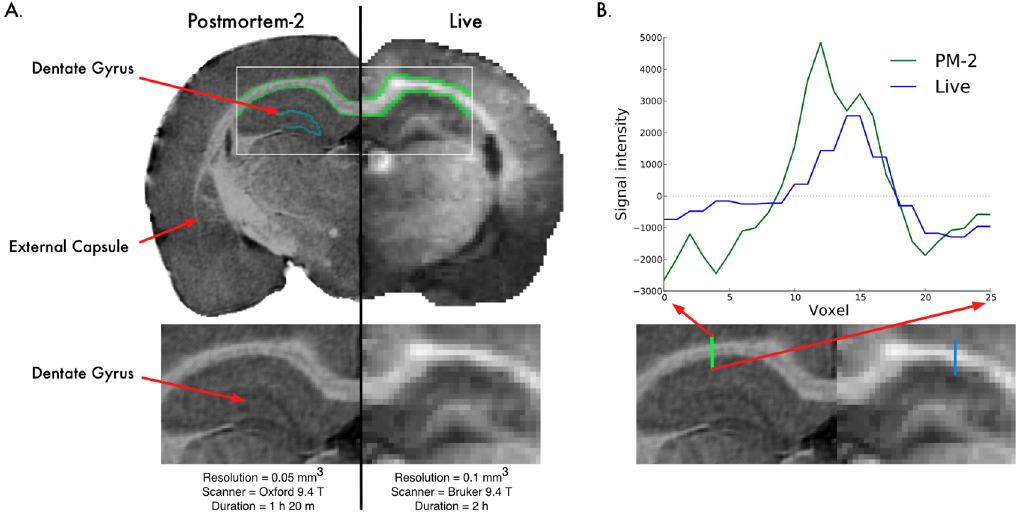
Figure 6. Image quality. (A) visual assessment. (B) intensity profile across the corpus callosum.